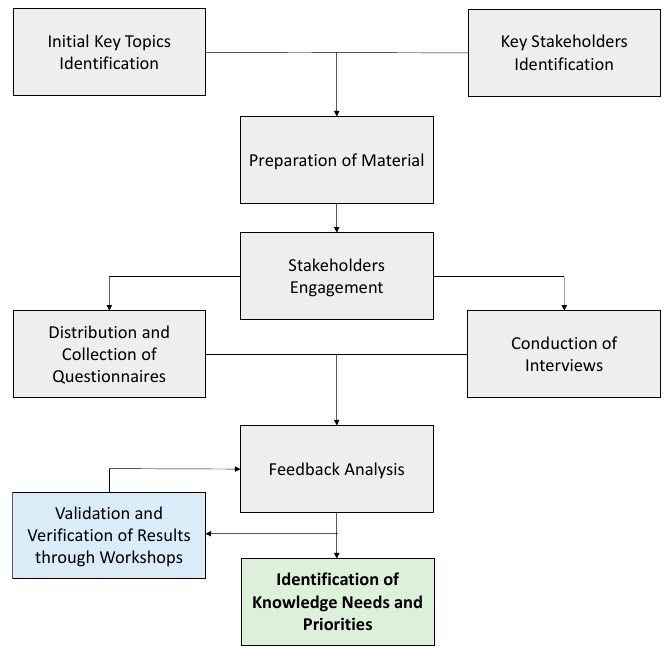
Figure 1. Methodology followed by POLIMP for identifying knowledge gaps on implications of possible directions of EU and international climate policies.